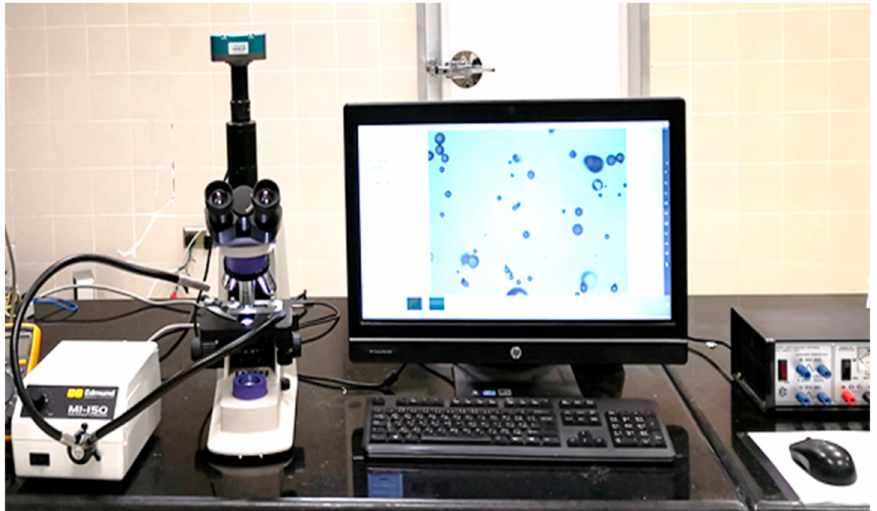
Figure 6. An image processing system for measuring the diameter and projected area of droplets produced by the designed ultrasonic humidifier. The system consists of a microscope with magnifica- tions of 40 × , a digital camera, a high-intensity illuminator, and an integrated desktop computer with the IS Capture